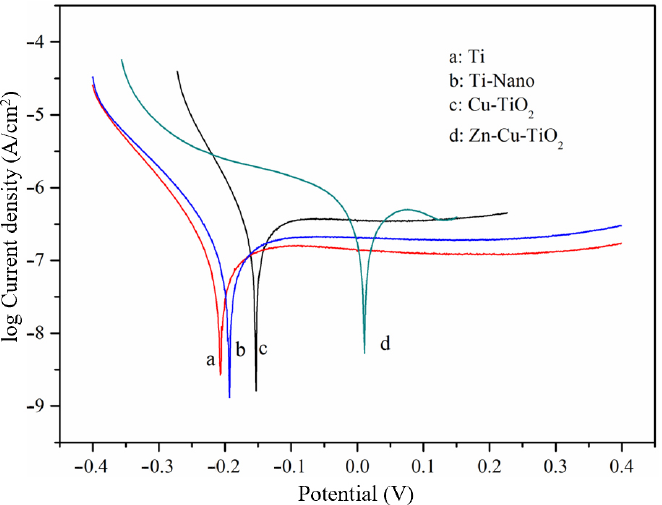
Figure 4. Tafel polarization curves for the different electrodes.